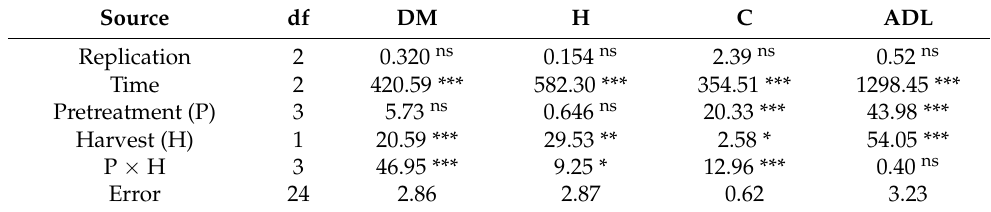
Table 2. Repeated measure ANOVA on degradation of giant reed dry matter (DM), hemicellulose (H), cellulose (C) and acid detergent lignin (ADL) during 10, 20, and 30-day fungal pretreatment ( I. lacteus and P. ostreatus ) in winter and autumn harvest. Degree of freedom (df) and adjusted mean square significance: p ≤ 0.001 (***), p ≤ 0.01 (**), p ≤ 0.05 (*), Not significant (ns). Source df DM H C ADL